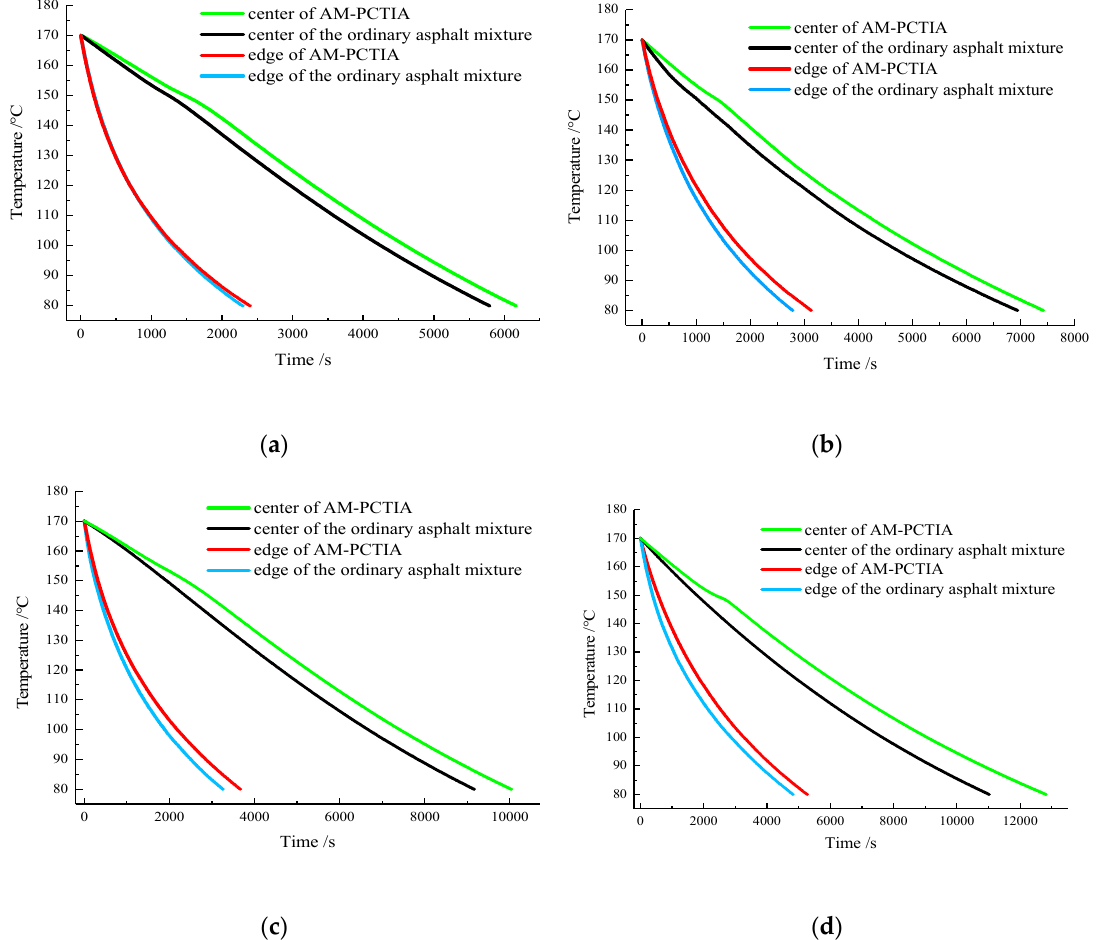
Figure 5. Temperature change curves of the two samples at different ambient temperatures: ( a ) 0 °C; ( b ) 5 °C; ( c ) 10 °C; ( d ) 15 °C.